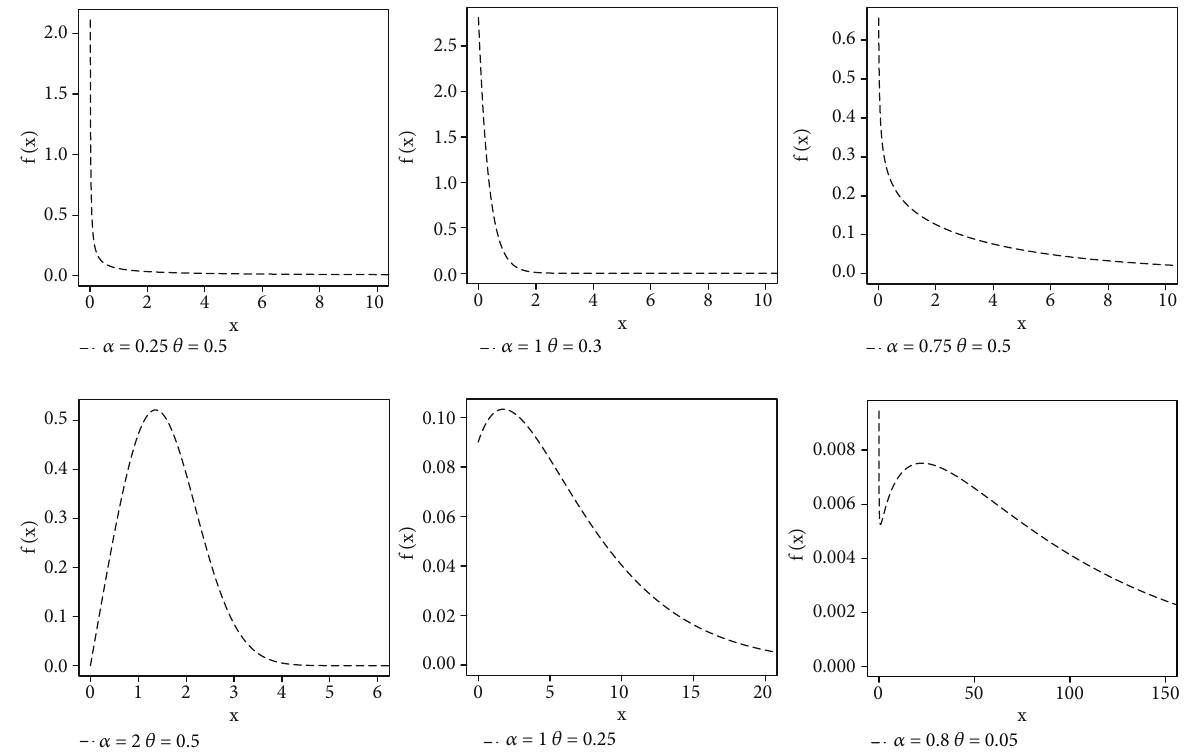
Figure 1: Plots of the PDF of PXL distribution for some parameter